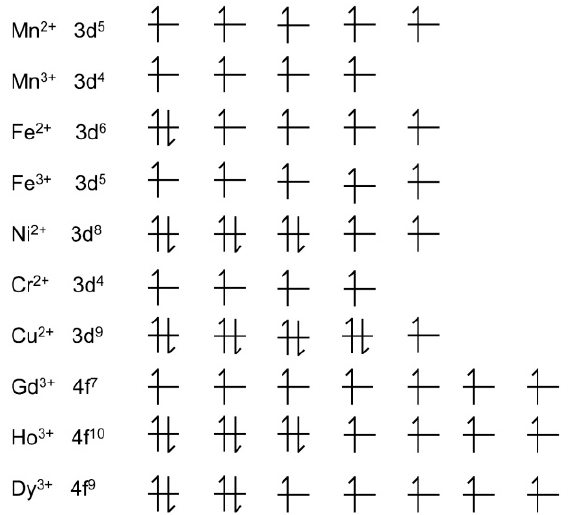
Figure 1. The electron subshell diagrams of typical paramagnetic cations. Generally, the larger number of unpaired electrons leads to stranger magnetic resonance (MR)